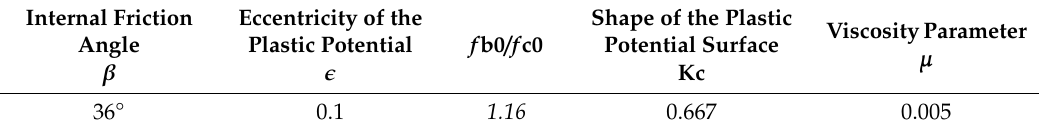
Table 3. Parameters of the Concrete Damage Plasticity